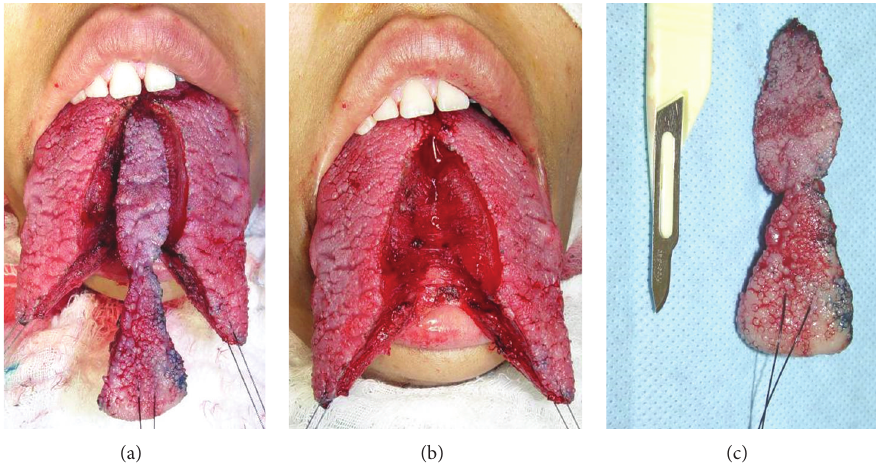
Figure 3: A partial thickness elliptical wedge incision starting at the midline and 4 mm distance from tongue taste buds using electrocautery, the dorsum, and incisions on belly anterior tongue were united resulting in a full-thickness flap, proceeding the excision of excess tissue.